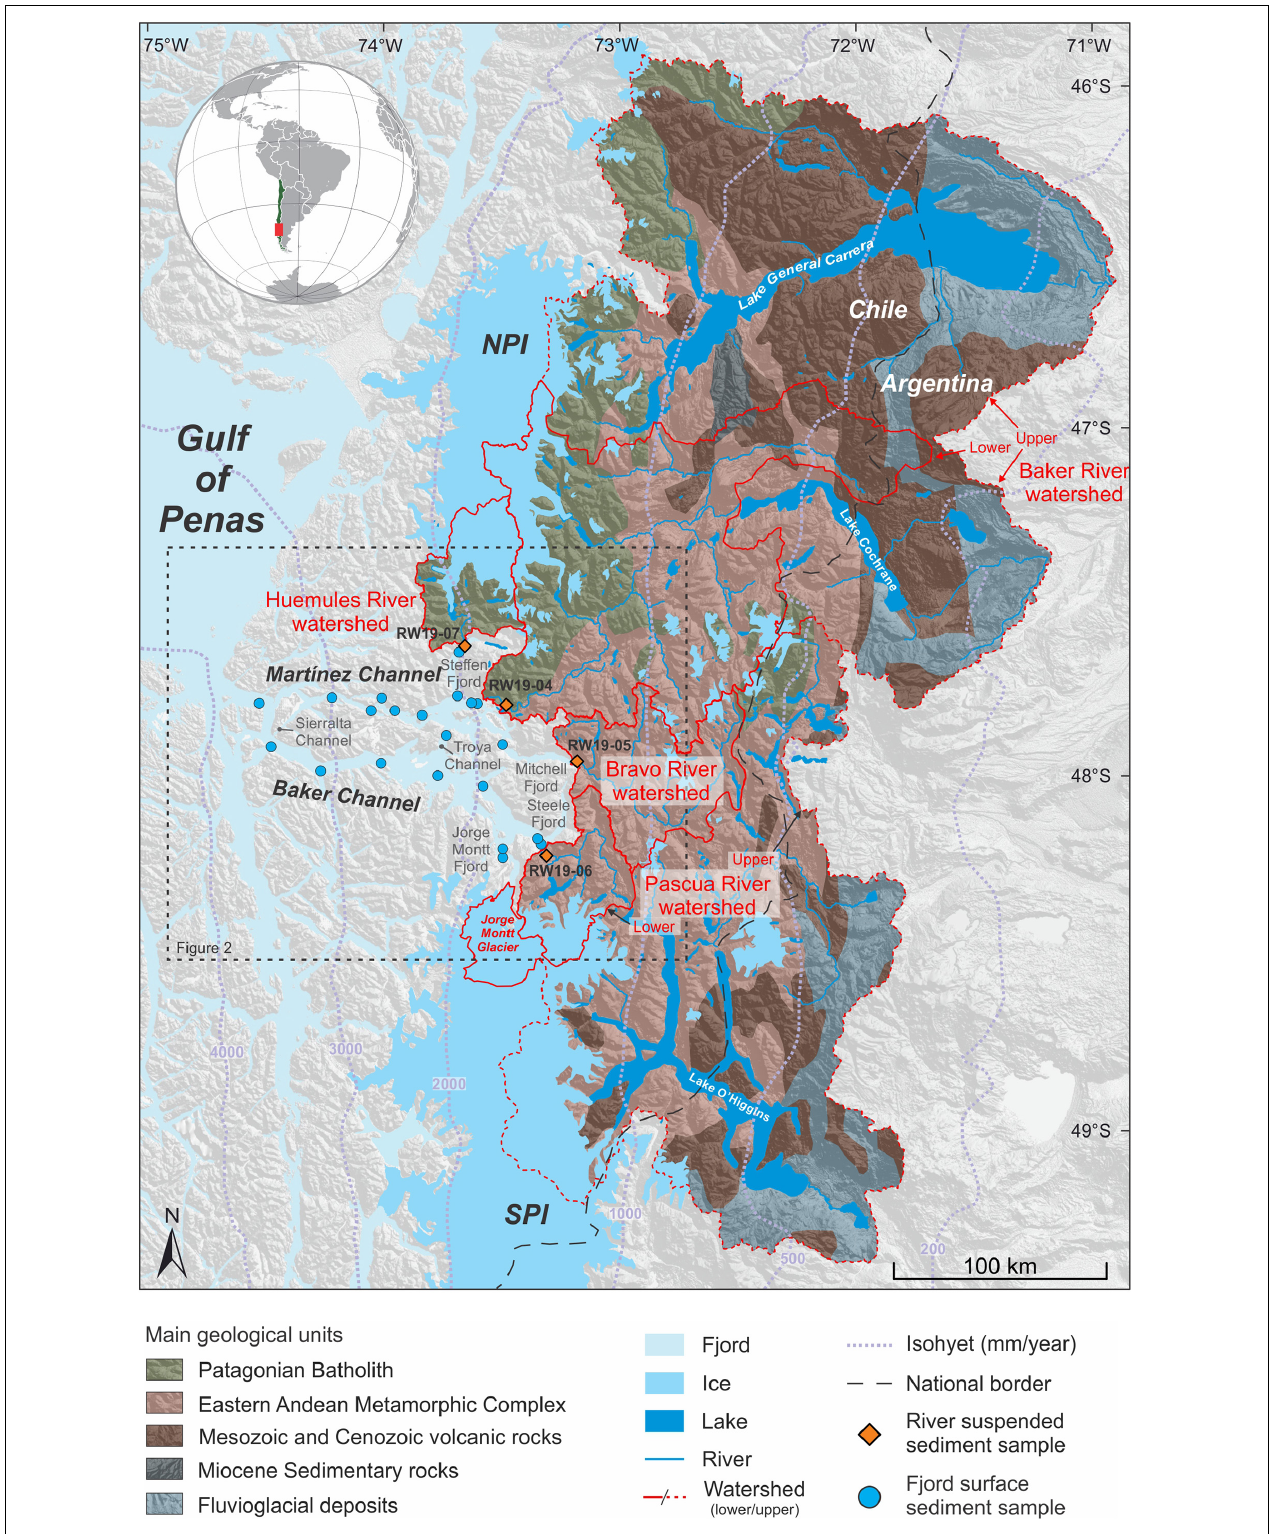
FIGURE 1 | Location of the Baker-Martínez fjord system in Chilean Patagonia with indication of the main geological units of the studied watersheds (Segemar, 2003; Sernageomin, 2003; Gómez et al., 2019), icefields (NPI and SPI; Northern and Southern Patagonian Icefield), mountain glaciers, and main rivers discharging in the fjord system. The mean annual precipitation (in mm) gradient is represented by purple dashed isohyets (Fick and Hijmans, 2017).